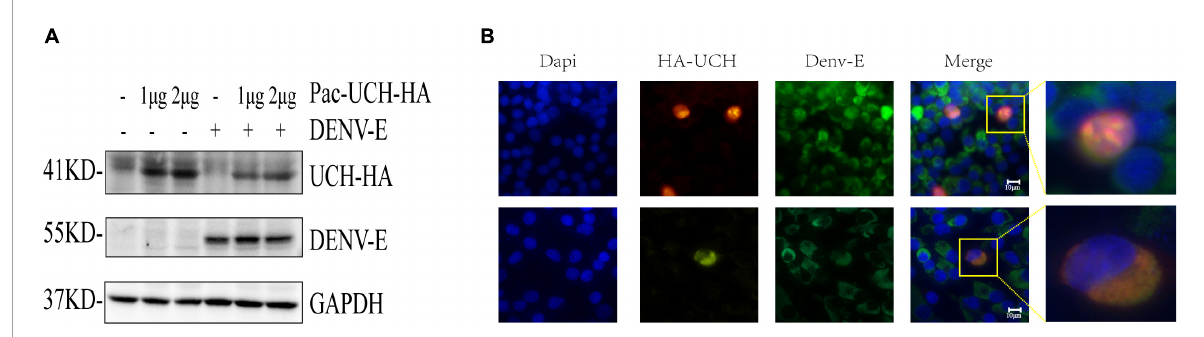
FIGURE6 DENV infection results in degradation of UCH. (A) pAC5.1b-myc-UCH-HA plasmids were transfected into C6/36 cells with a gradient of 0, 1, and 2 µ g, and DENV (MOI = 1) was infected 48 h after transfection. Cellular proteins were extracted at 24 hpi. (B) 1.5 µ g of pcDNA3.1 (+)-UCH-HA plasmids were transfected into BHK-21 cells, and 24 h after transfection, dengue virus (MOI = 1) was infected. The cells were fixed at 24 hpi for immunofluorescence assay. Localization of DENV-E and HA-UCH were detected by co-immunostaining with antibodies to fluorescent secondary antibody (green) and HA tag (red). Nuclei were stained with DAPI (blue). The upper and lower images in each column are of two fields of view in the same